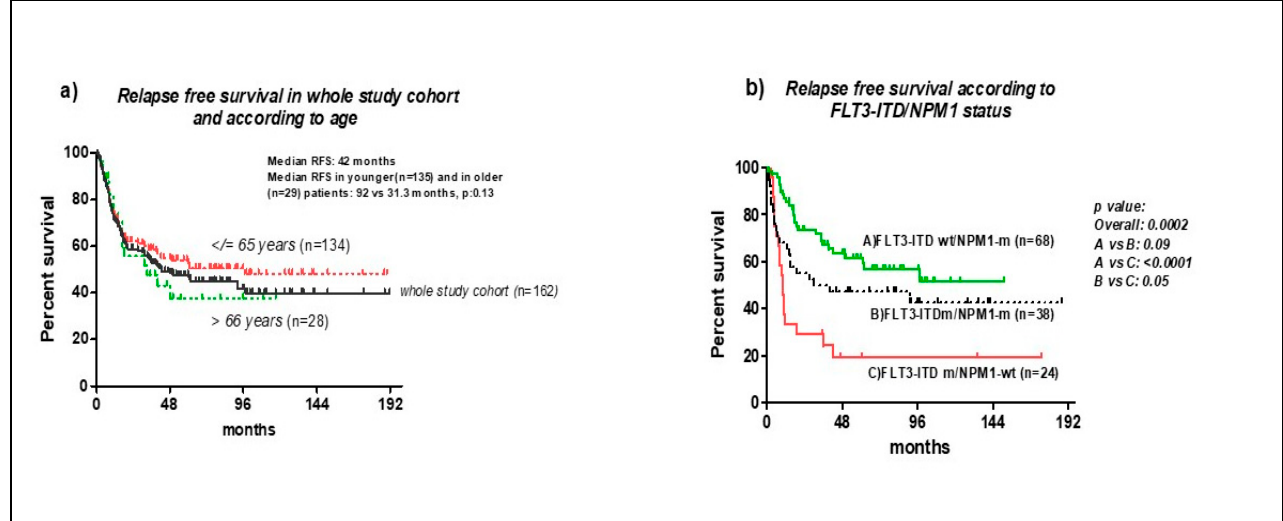
Figure 2. Relapse-Free Survival (RFS): ( a ) in the whole study cohort and according to age. ( b ) Accord- ing to molecular data ( NPM1 / FLT3 -ITD): NPM1 m/ITDwt vs. NPM1 wt/ITDm, vs. NPM1 m/ITDm. RFS was not significantly different among the NPM1 -mutated, with or without con- comitant FLT3 -ITD [3-y survival 67% +/ − 5 (SE) and 50% +/ − 8 (SE), respectively, p : 0.09] (Figure 2b). The allelic burden did not impact their RFS ( p : 0.5), whereas patients with isolated FLT3 -ITD had a significantly lower RFS (3-y 24%, p : 0.0002) (Figure 2b). In TKDm patients, RFS was intermediate between the NPM1 m and ITDm patients, and it was not influenced by the presence of the NPM1 mutation [3-y RFS: 41% +/ − 14 (SE) and 47% +/ − 11 (SE) in the NPM1 wt and in NPM1 m patients, respectively; p :